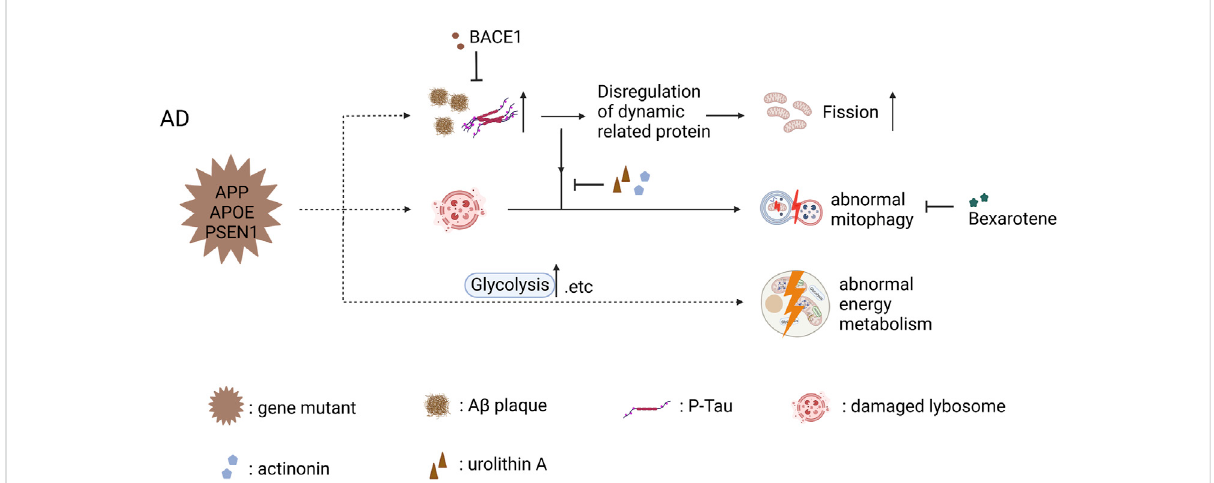
FIGURE 2 Mitochondrial dysfunction in AD iPSC-derived neurons (carrying APP, APOE, and PSEN1 mutant) and therapeutic strategies (created with BioRender.com). Abnormal accumulation of A β and p-Tau disrupted the balance of mitochondrial fusion and fi ssion and increased mitochondrial fi ssion in cortical neuron carrying PSEN1 mutant, and BACE1 inhibited the abnormal accumulation of A β and p-Tau to ameliorate mitochondrial fi ssion.AbnormalaccumulationofA β andp-Taudecreasedthelevelsofactivatedmitophagyproteins,leadingtotheabnormalmitophagyinAD iPSC-derived cortical neurons; actinonin, urolithin A and bexarotene are able to restore abnormal mitophagy through their own mechanism. AD iPSC-derived astrocytes showed abnormal energy metabolism including increased mitochondrial respiration and elevated glycolytic